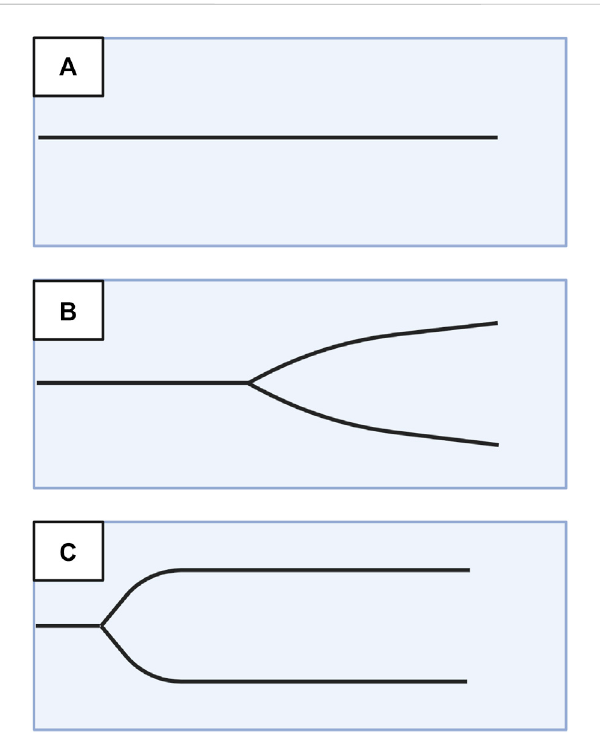
FIGURE 11 Evolution of Thromboelastography (TEG) Tracings During Resuscitation of a Patient with Amniotic Fluid Embolism. During induction of labor, a 35-year-old woman had a sudden cardiac arrest due to amniotic fl uid embolism (AFE). She developed immediate disseminated intravascular coagulation, respiratory failure, and renal failure requiring mechanical ventilation and dialysis. Immediate delivery of the fetus by cesarean section was followed by normal APGAR scores at 9 min. Both child and mother were discharged from the hospital with no residual complications. TEG tracing (A) demonstrates a fl at line indicating no clot formation. Two hours after the fi rst blood draw, the laboratory called to say that the aPTT was excessively prolonged and must be a laboratory error. TEG tracing (B,C) show gradual improvement of TEG tracings at 2 and 8 h following cardiac arrest. Resuscitation required in total 12 units of